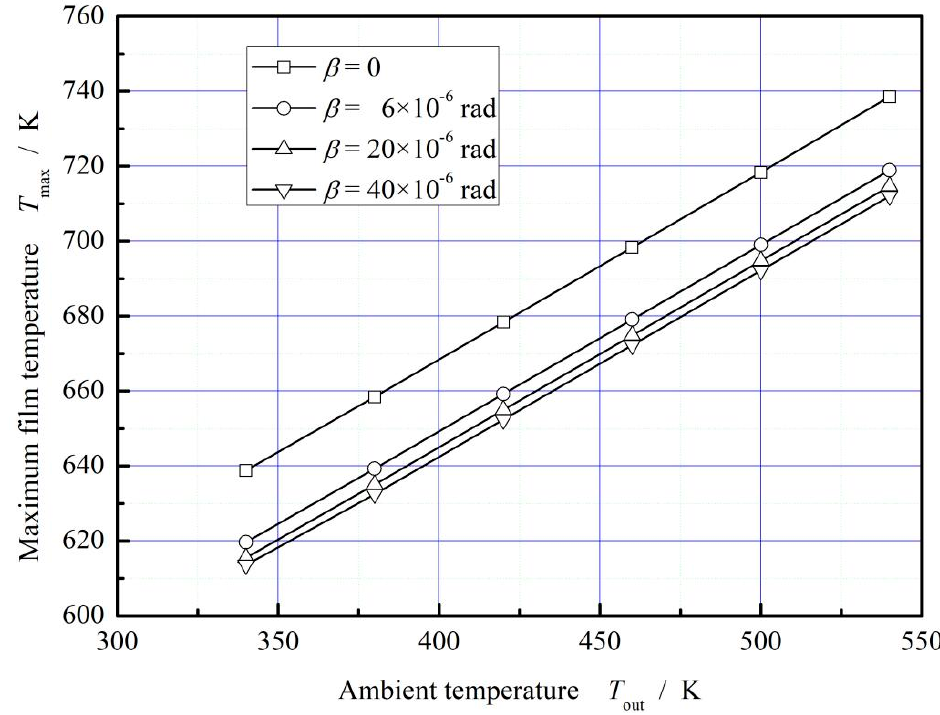
Figure 18. Influence of rotation speed on the maximum temperature of gas film. ( p i = 0.2 MPa, ω = 3.0 × 10 4 r/min, T in = 580 K).